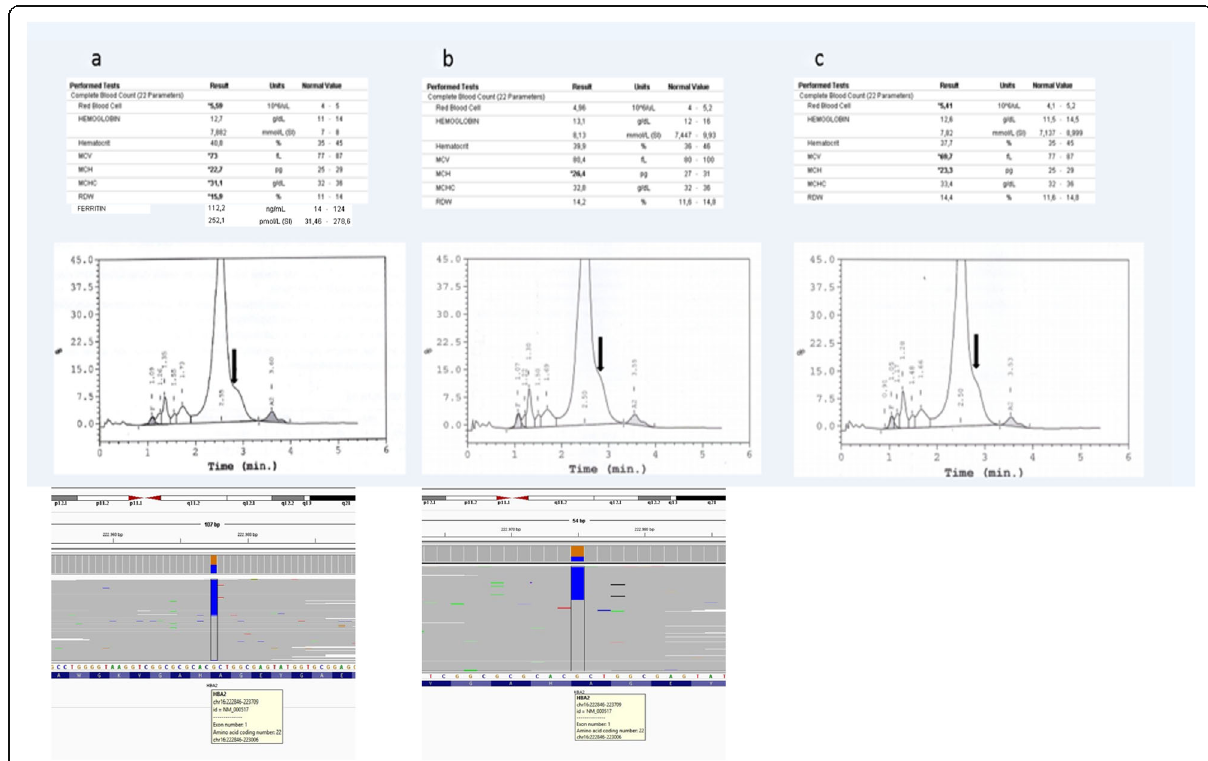
Fig. 1 CBC, HPLC chromatograms, and HBA2 gene. The figure includes the HPLC histograms and HBA2 gene sequence analysis below the complete blood count and ferritin levels of the patient ( a ), his mother ( b ), and sister ( c ). The asymmetry (shoulder formation) in the descending part of A0 and in the A2 curve was indicated with an arrow on the